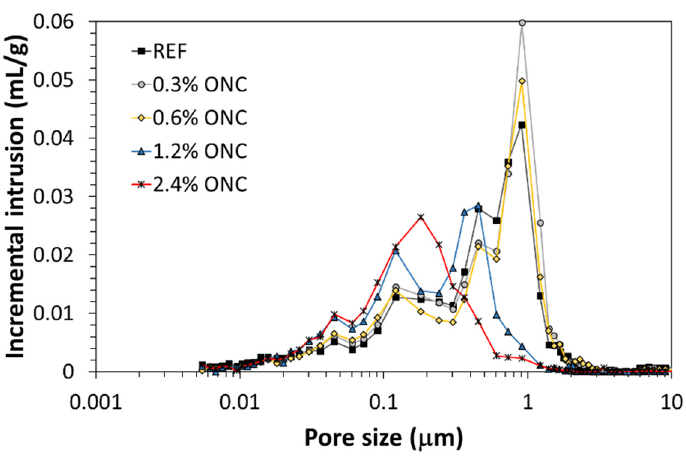
Figure 12. Pore size distribution of mortars with different ONC content.